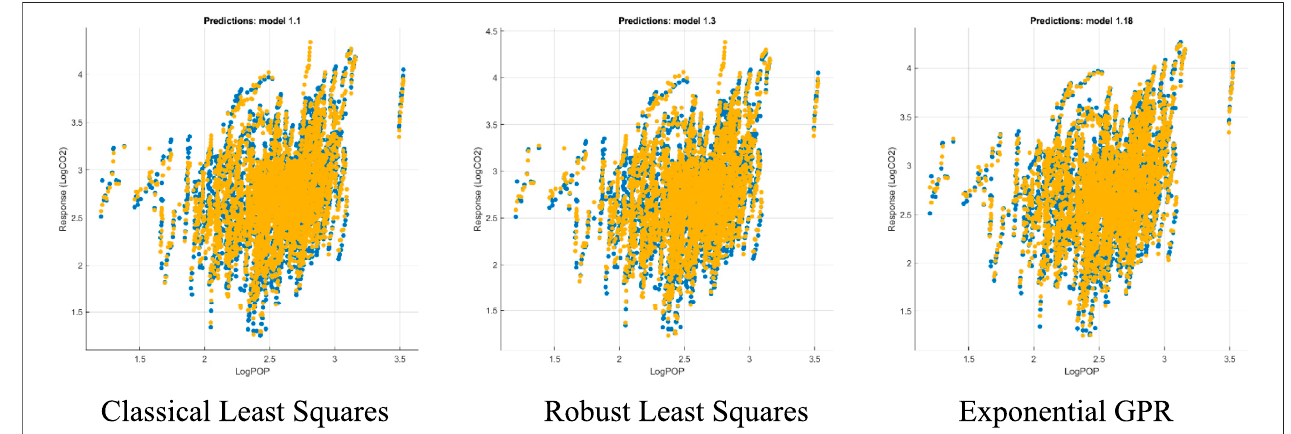
FIGURE 4 | Comparing actual and predicted CO 2 emissions against population size of the selected models. Classical Least Squares, Robust Least Squares, ExponentialGPR.Notes:1)TheverticalaxisrepresentsthevalueofCO 2 emissionsinlogarithm.2)Thehorizontalaxisrepresentsthepopulationsizeinlogarithm.3)CO 2 emissionsaremeasured in10,000 tonsofstandardcoal. 4)Thebluedotsrepresent actual valueswhereastheyellowdots represent thepredicted values.5)Theunitof population is 10,000 people.